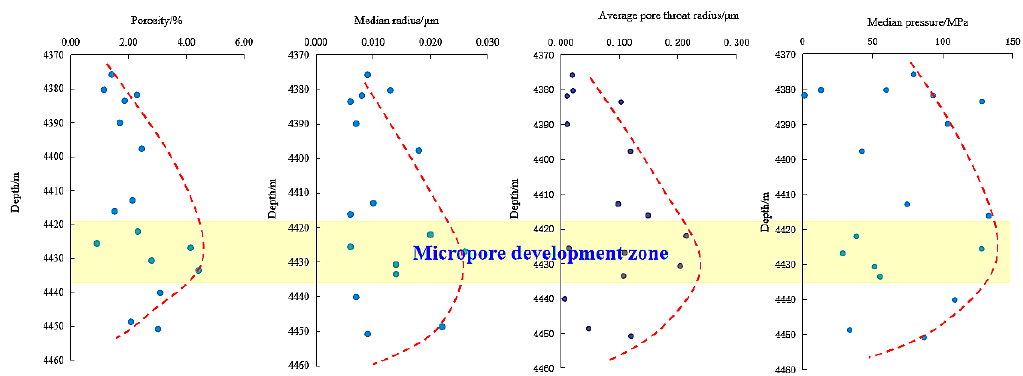
Figure 4. Comparison of microscopic pore development zones. Table 2. Analysis table of eyelid and eyeball-shaped limestone pore throat structures in the first member of Maokou Formation of Xintan Well 1.